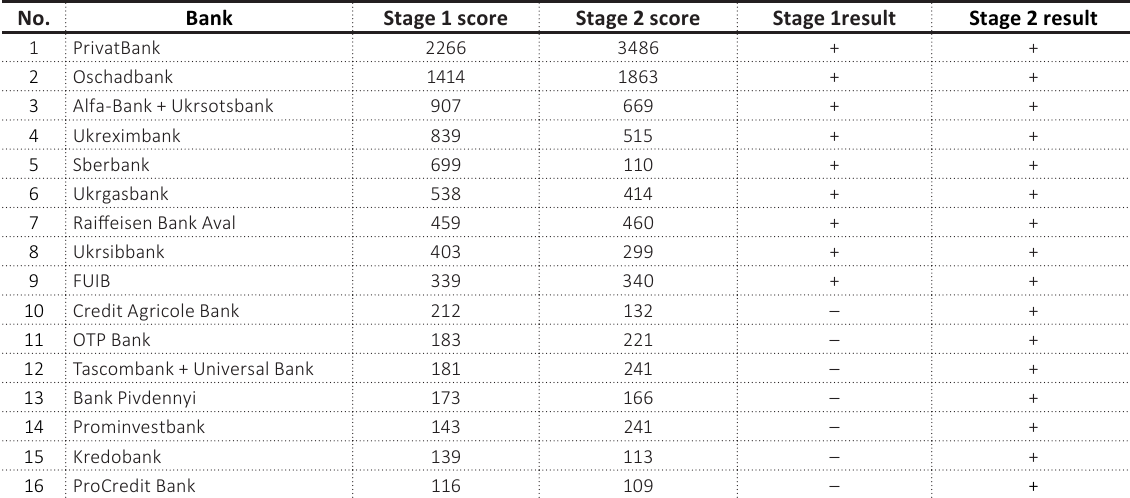
Table 4. Testing results of the NBU assessment methodology (as of January 1, 2019)